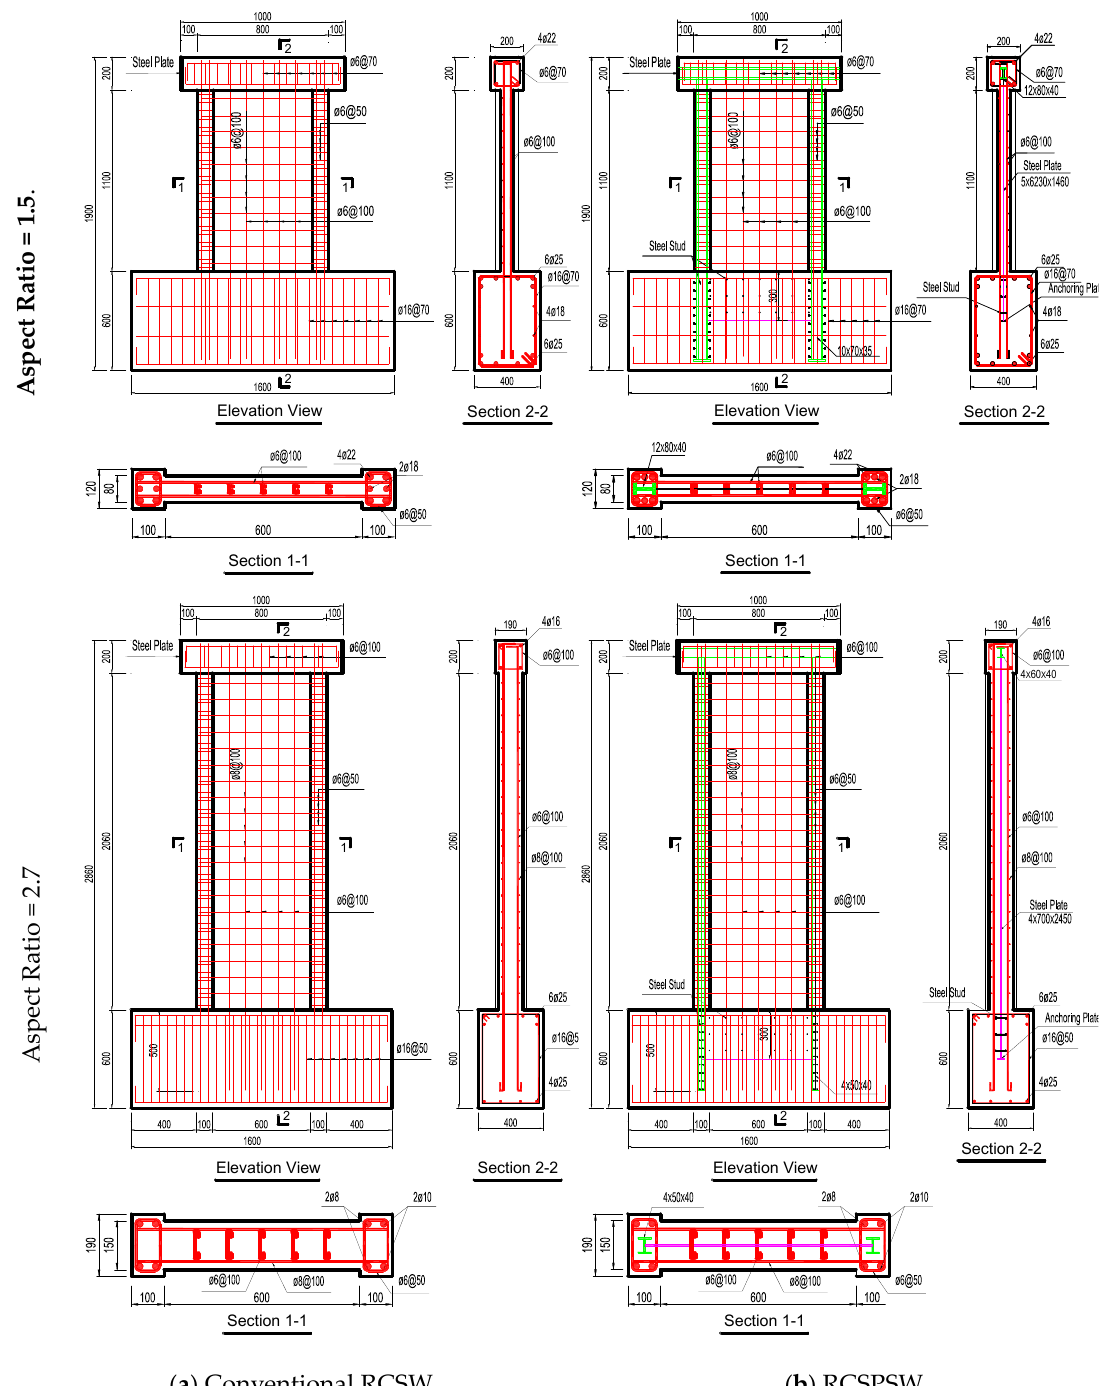
Figure 2. Cross-sectional Dimensions and Reinforcement Details of RCSW and RCSPSW.